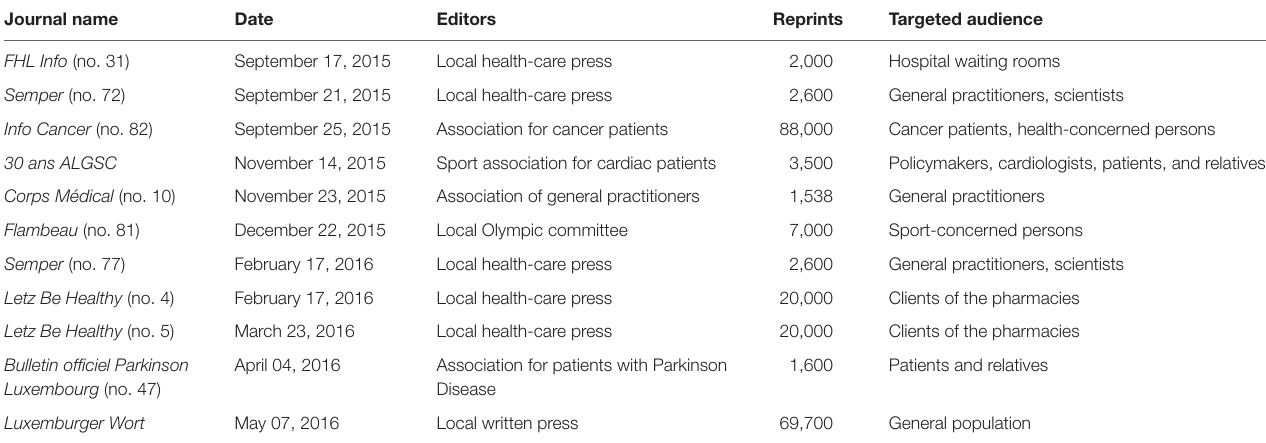
TaBle 2 | list of the published popular science articles aiming to promote sport-santé in